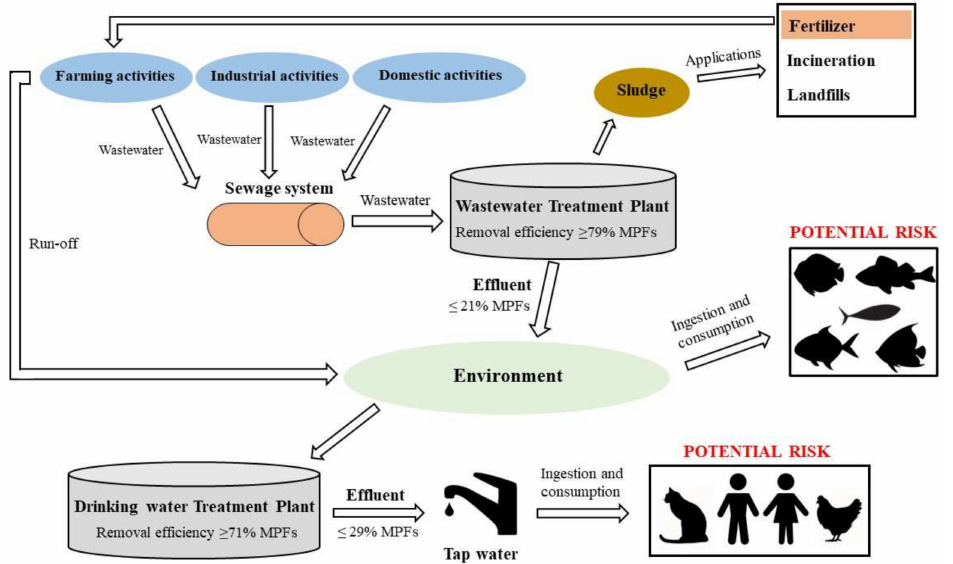
Figure 1. A possible route of entry of MPFs into living beings via WWTPs and